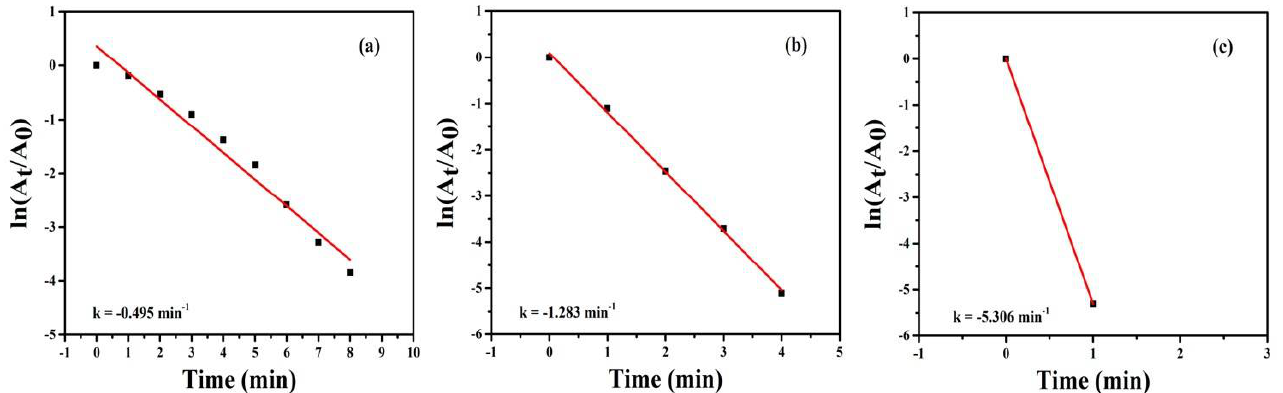
Figure 8. Plots of ln(At/A0) as a function of the reaction time for 4-NP reduction via ( a ) CoPt, ( b ) rGO/CoPt, and ( c ) rGO/CoPt/Ag.